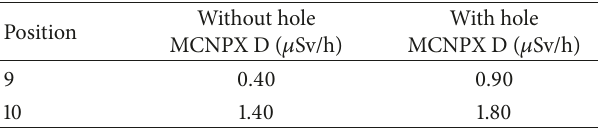
Table 1: Comparison of dose rate without and with hole at the labyrinth entrance door obtained with MCNPX code with ∗ F 5